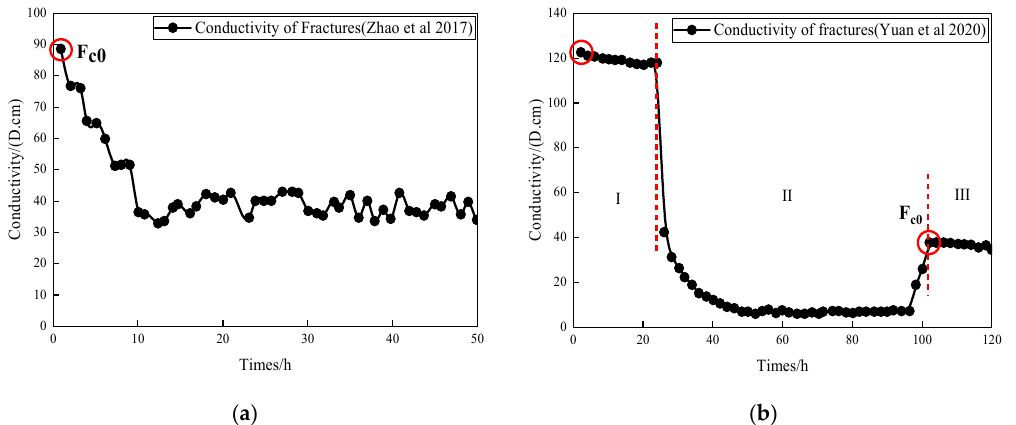
Figure 1. Long-term conductivity test. ( a ) Long-term conductivity test. ( b ) Long-term conductivity test (considering liquids).